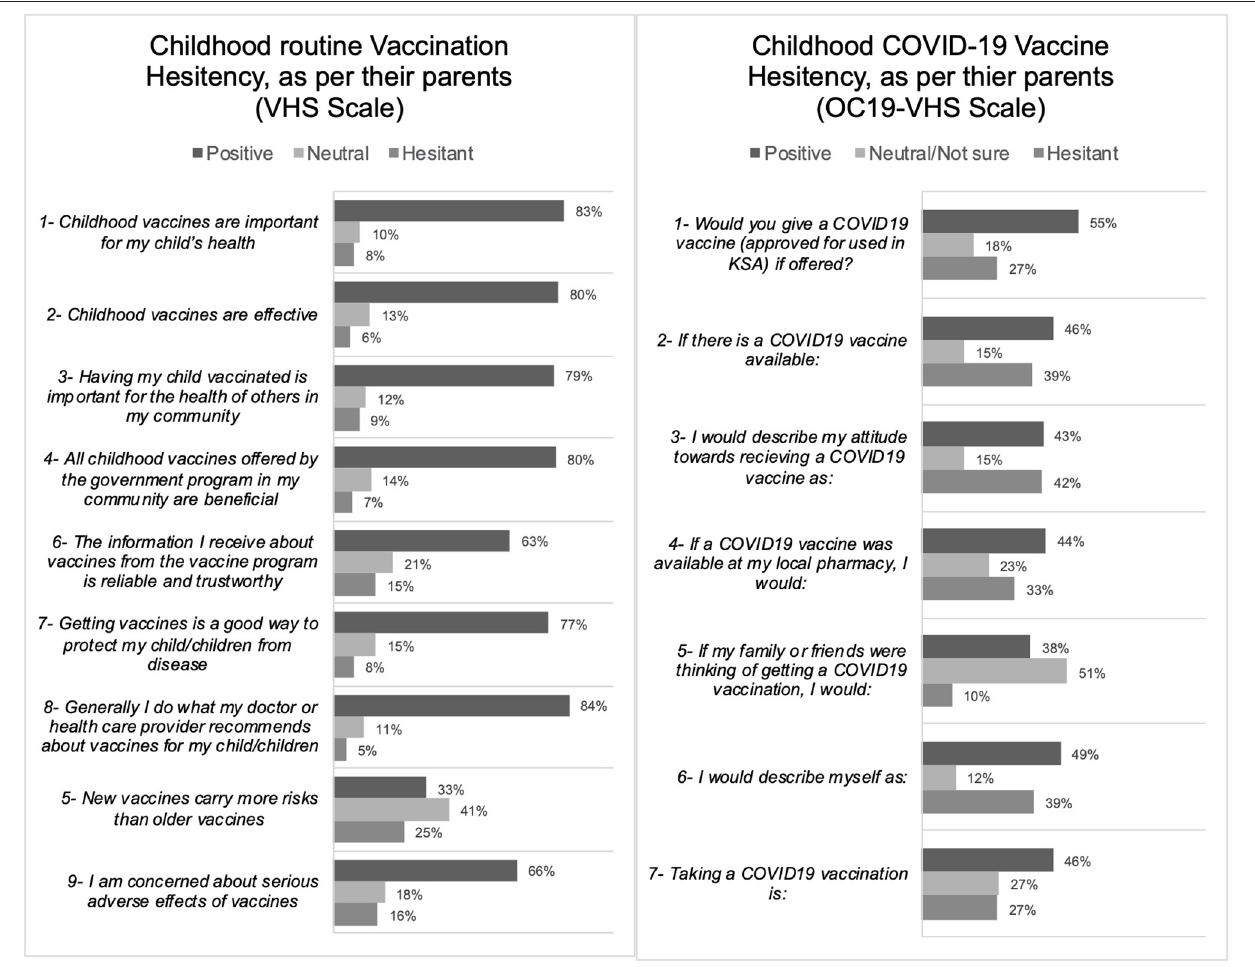
FIGURE 2 | The frequencies of endorsement of each item are categorized into hesitant (Category 4 and 5), positive (Category 1 and 2), or neutral ( n = 1,052).